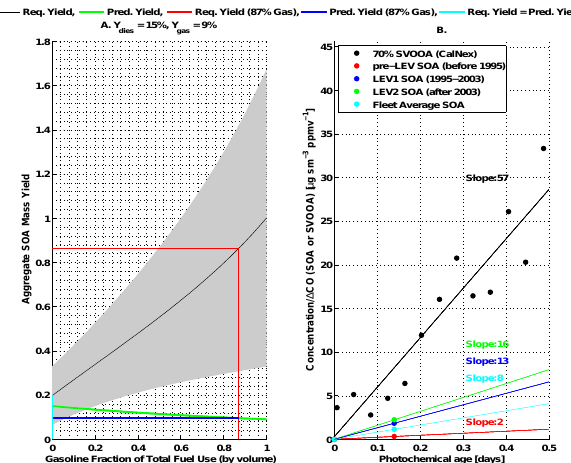
Fig. 5. Same as Fig. 3, except emission factors for gasoline-fueled vehicles and aggregate SOA mass yields are based on the experi- mentally derived values reported in Gordon et al. (2013). (A) Ag- gregate SOA mass yield for gasoline exhaust is 9%, which is con- sidered representative of the California LDGV fleet. (B) Measured PMF SV-OOA factor concentrations normalized by CO enhance- ment ( 1 CO is the ambient CO minus the estimated background CO, 105ppb) as functions of photochemical age. Also shown are exper- imentally derived SOA/ 1 CO enhancements resulting from pho- tooxidation of tail-pipe emissions from 15 LDGVs recruited from the California in-use fleet. All LDGV experiments were conducted in a portable chamber under urban-like conditions, and all LDGV data are taken directly from Gordon et al.